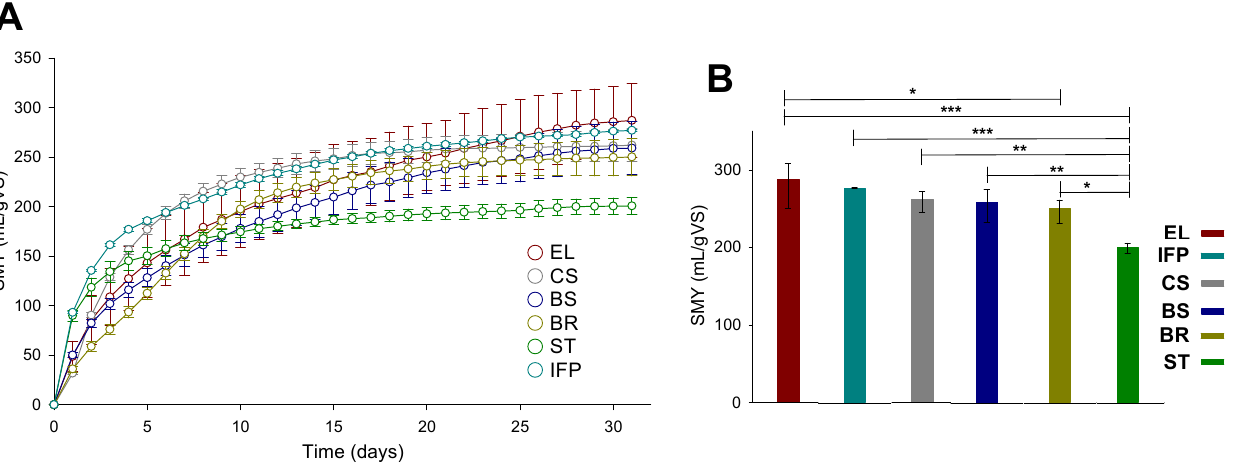
Figure 1. Specific methane yield (SMY) of the different insect frass samples. ( A ): Elodea nutallii (EL), corn silage (CS), brewers spent grain (BS), bran (BR), stillage (ST), and insect frass (IF_PP). Effect of different substrates on SMY ( B ). Data are mean ± standard deviation ( n = 3) for each insect frass sample. * p < 0.05, ** p < 0.01. *** p < 0.001 (one ‐ way ANOVA with Sidak post ‐ test).